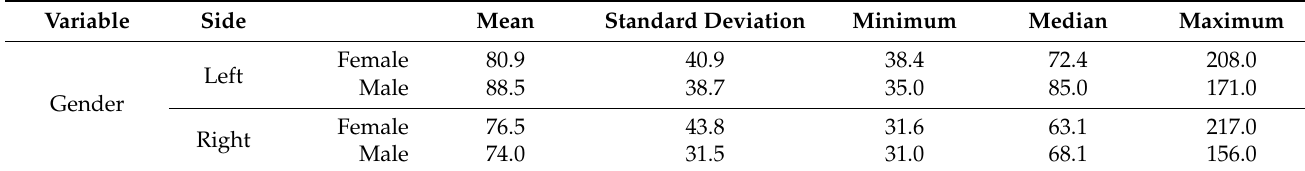
Table 1. Position and dispersion measurements of agger nasi cells by gender.